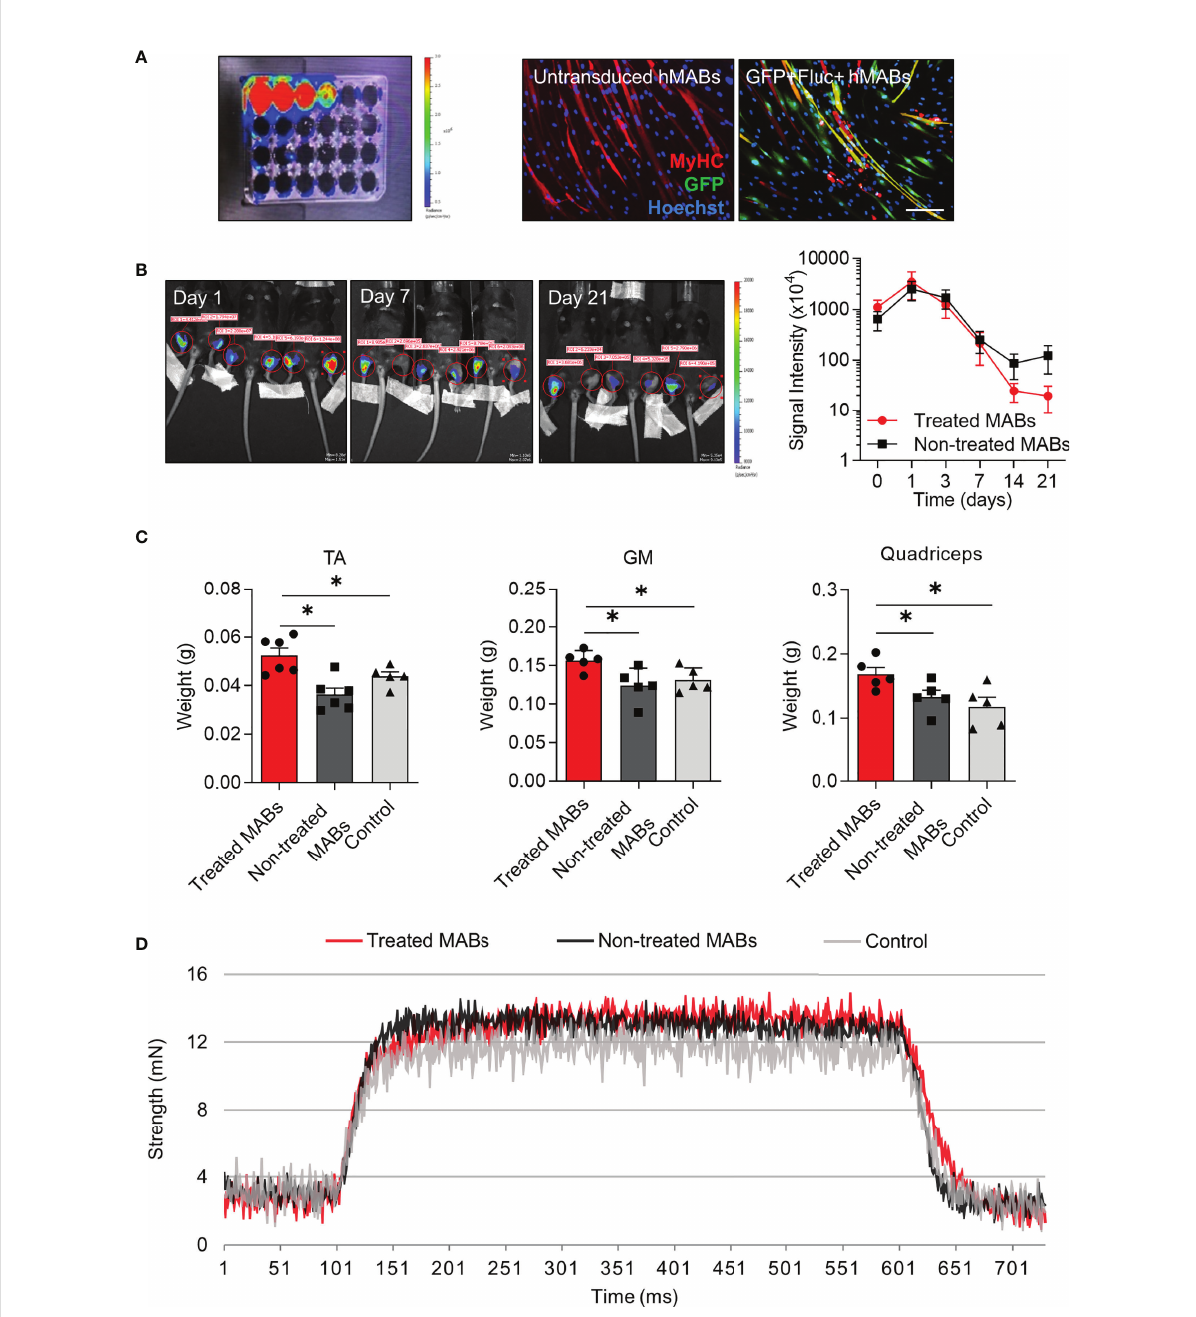
FIGURE 4 Cell transplantation of microRNA-treated and non-treated human mesoangioblasts in aged mice after acute injury. (A) Bioluminescence of human mesoangioblasts (hMABs) cultured in vitro transduced with the enhanced green fl uorescent protein (eGFP)/ fi re fl y luciferase vector (left) and immuno fl uorescence analysis for myosin heavy chain (MyHC) (red) and GFP (green) in differentiated hMABs with and without transduction. Hoechst was counterstained in blue. Scale bars: 50 µm. (B) In vivo bioluminescence imaging at days 7, 14, and 21 in injected mice (left) and signal quanti fi cation (right). Left limbs received microRNA-treated MABs, right limbs received non-treated MABs. (C) Weight of hindlimb muscles after mice were sacri fi ced at day 21. TA: Tibialis anterior, GM: Gastrocnemius. (D) Functional analysis of extensor digitorum longus via evaluation of tetanic force. One-way ANOVA was used and results are displayed as mean±s.e.m (n = 5-6 muscles/group, *p <